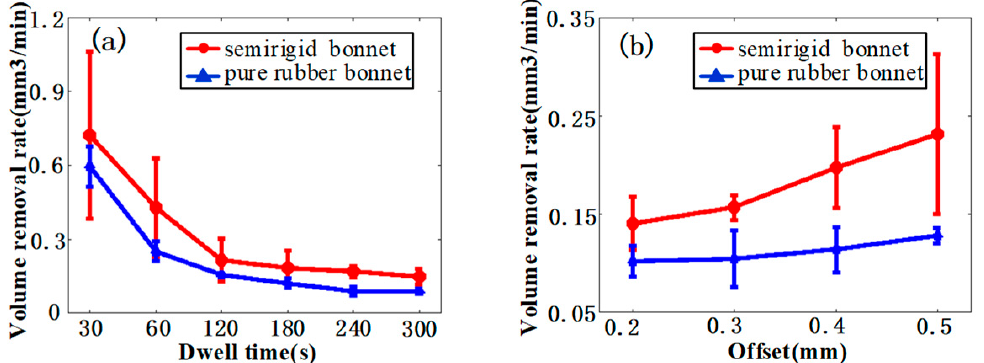
Figure 5. ( a ) Volume removal rate of TIFs under different dwell time, and ( b ) volume removal rate of TIFs under different offset. Table 4. Section size of polishing point.